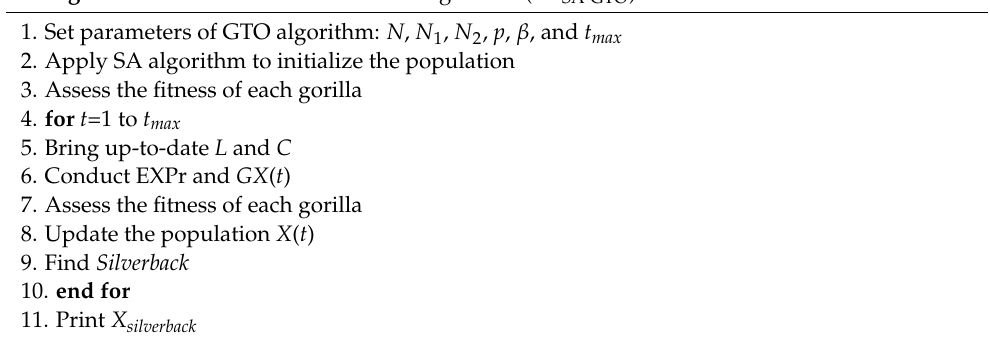
Algorithm 2 Pseudo-code of SA-GTO algorithm (PC SA-GTO